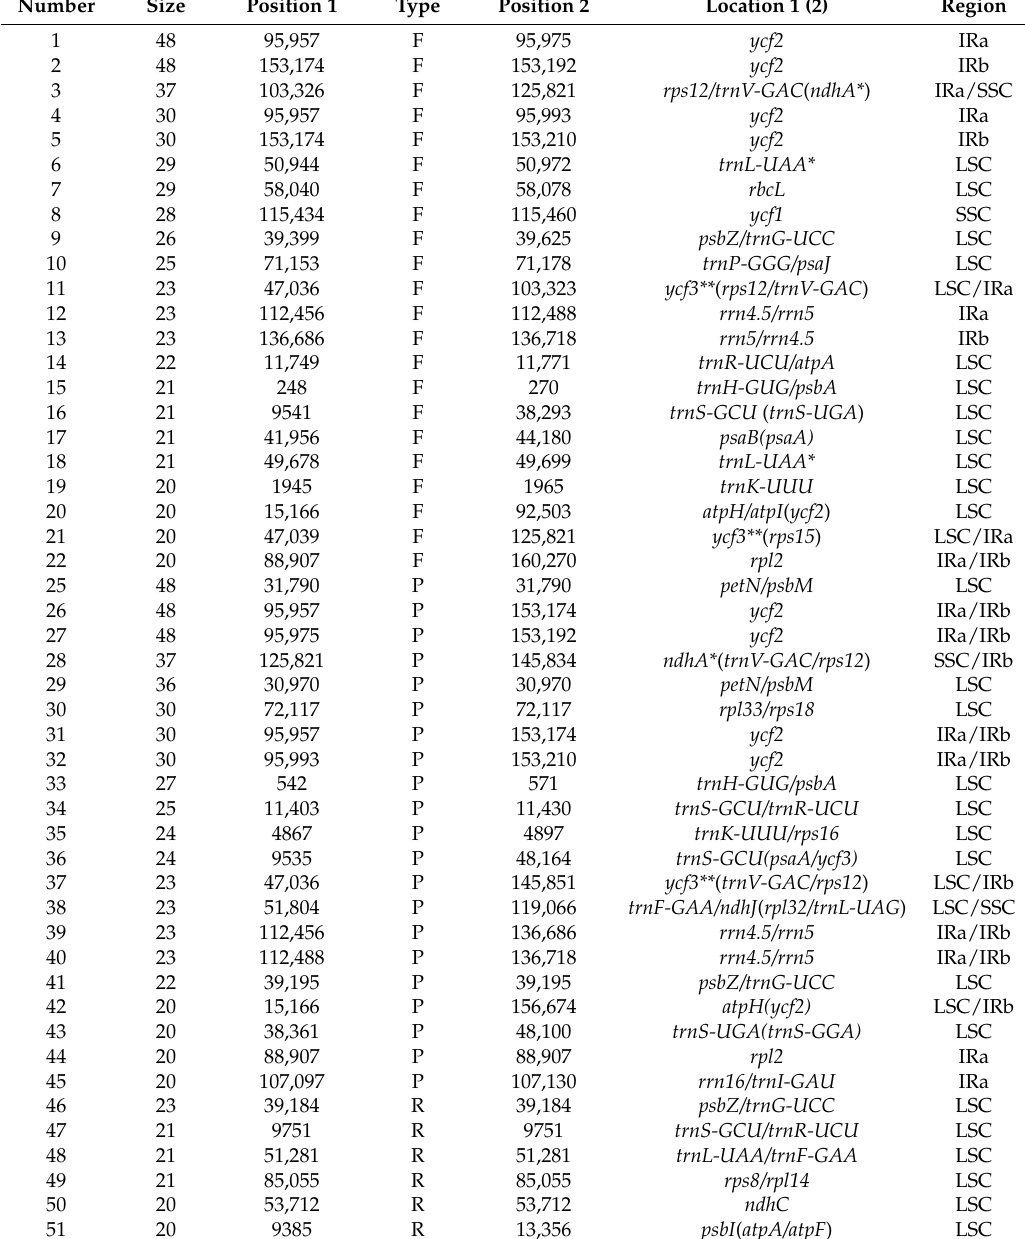
Table 4. Distribution and localization of repetitive sequences F, forward: P, palindromic, R; reverse in A. altissima chloroplast